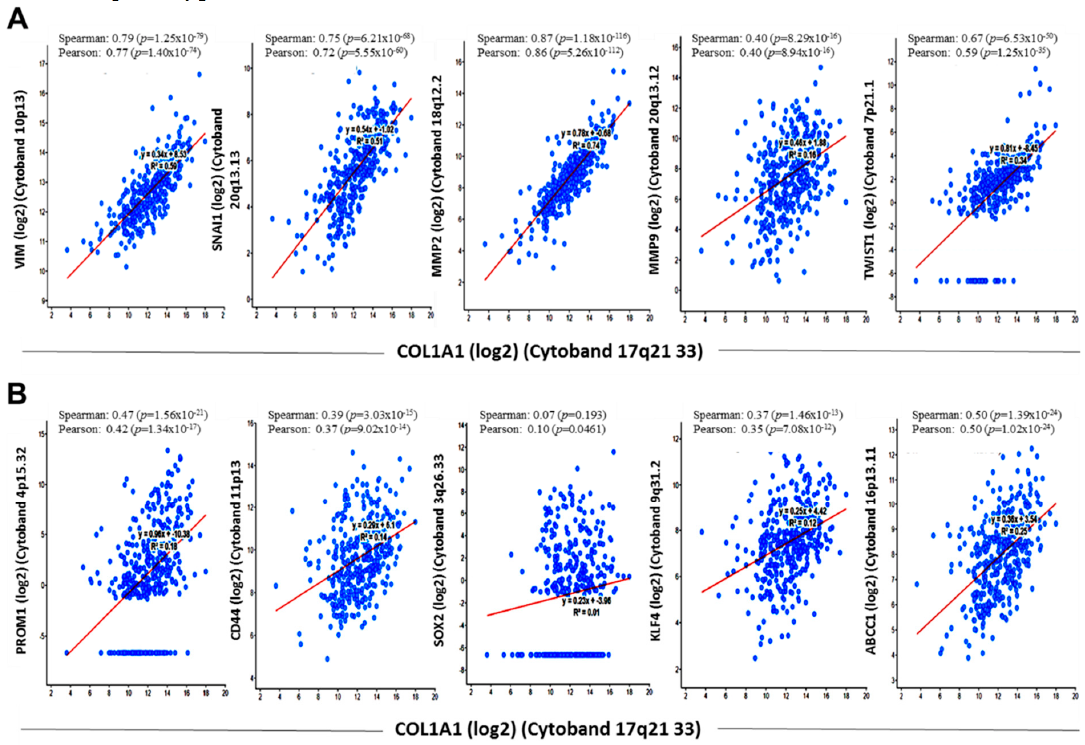
Figure 4. COL1A1 is strongly associated with and is a probable bridge between the metastatic and CSC-like phenotypes of HCC. Scatter plot showing the correlation between the expression of COL1A1 mRNA and that of ( A ) VIM, SNAI1, MMP2, MMP9 and TWIST, as well as ( B ) PROM1, CD44, SOX2, KLF4 and ABCC1 mRNAs in the provisional TCGA LIHC mRNA data (RNA Seq V2) cohort (371 patients/373 samples).